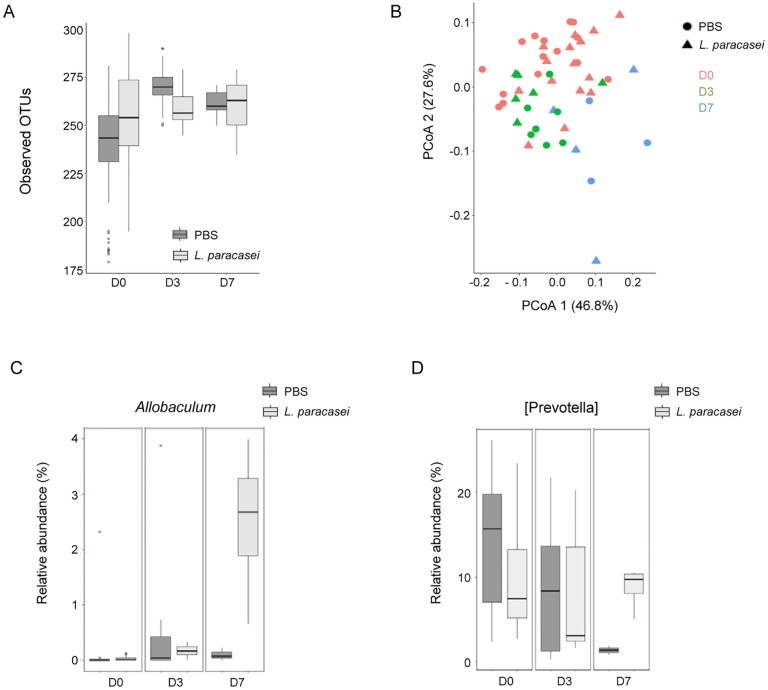
Impact of consumption of L. paracasei CNCM I-1518 on gut microbiota.(A) Alpha-diversity measured by number of OTUs before and after influenza infection. (B) Weighted Unifrac PcoA before and after infection infection (D0, D3 and D7). (C) Relative abundance (%) of Allobaculum through the experiment. (D) Relative abundance (%) of Prevotella through the experiment.